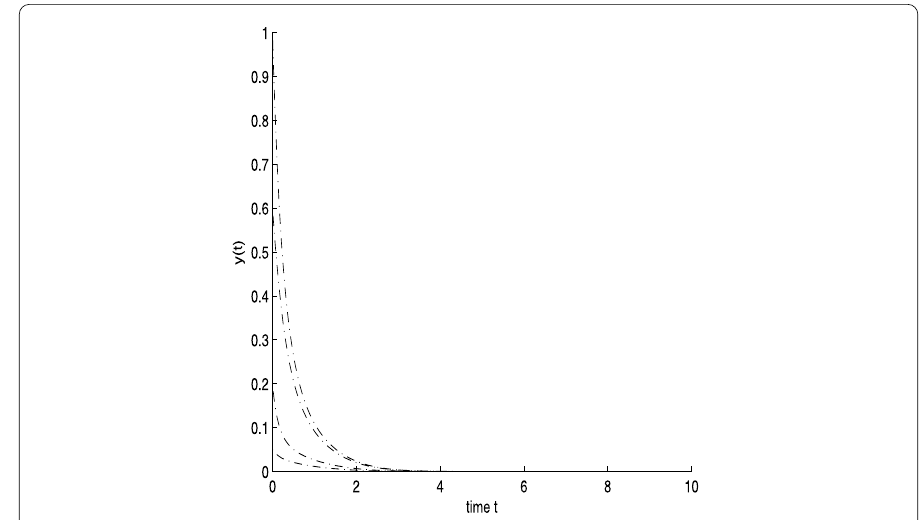
Figure 4 The extinction of the predator population of the system (5.3), with the initial condition condition ( x (0), y (0)) = (6,1),(4,0.6),(0.5,0.2) and (1,0.05)